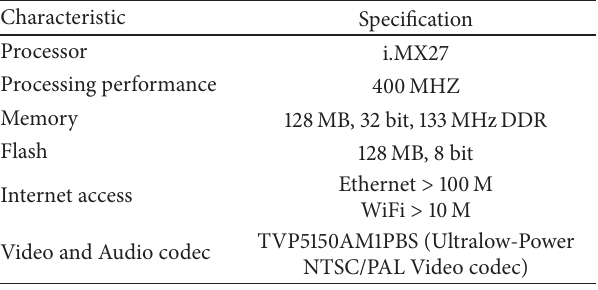
Table 1: Embedded System Specification